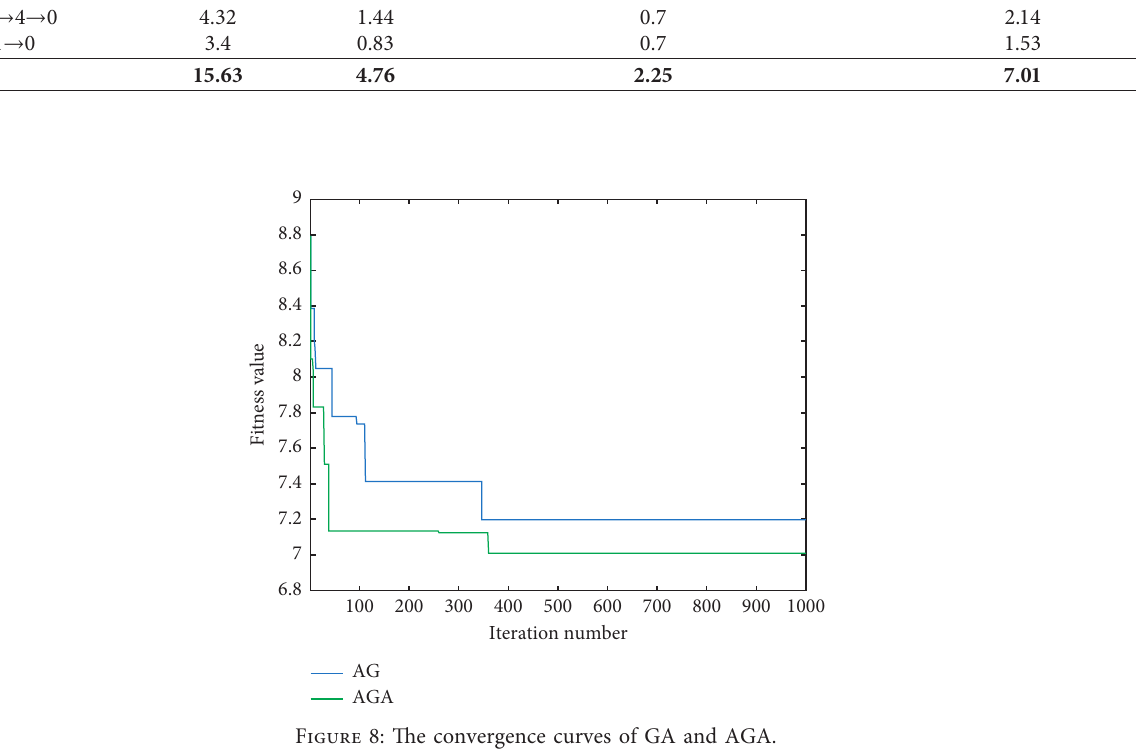
Table 5: Distribution paths and related results in the case of λ